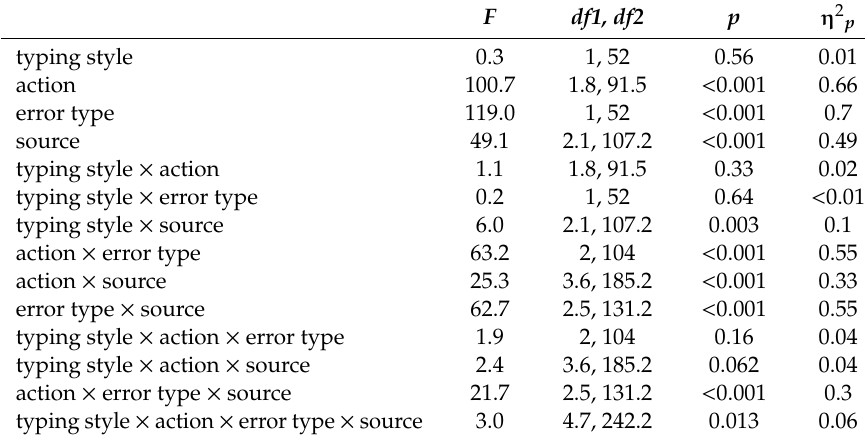
Table 4. Statistical values of the ANOVAs on the number of reported errors. Factors and factor levels were action (execution with visible screen, execution with covered screen, imagination), error type (higher-order planning, motor command), source (reviewing the planning process, vision of the screen, vision of the keyboard, kinesthesis / touch, internal monitoring), and typing style (ten-finger typists and hunt-and-peck